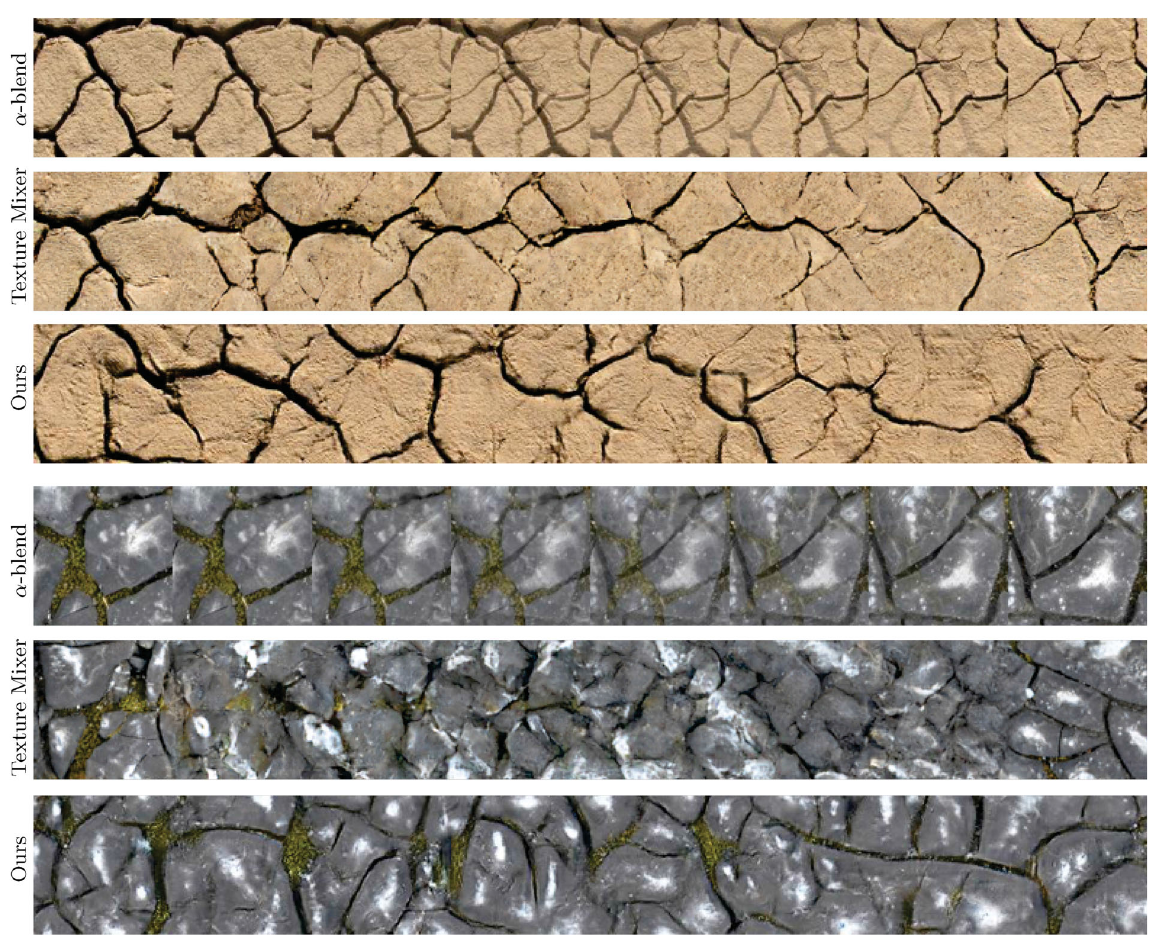
Fig. 10 Interpolation comparison. We compare interpolation results obtained with α -blend (top rows), Texture Mixer [29] (middle rows), and our method (bottom rows). The interpolation stripes are of size 1024 × 128 pixels. As illustrated above, our interpolations tend to be smoother and less repetitive than those of Texture Mixer.